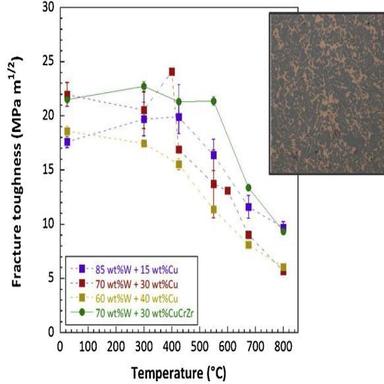
Fracture toughness of W-particle reinforced Cu and CuCrZr; microstructure of one of three industrially produced batches of Wp-CuCrZr.